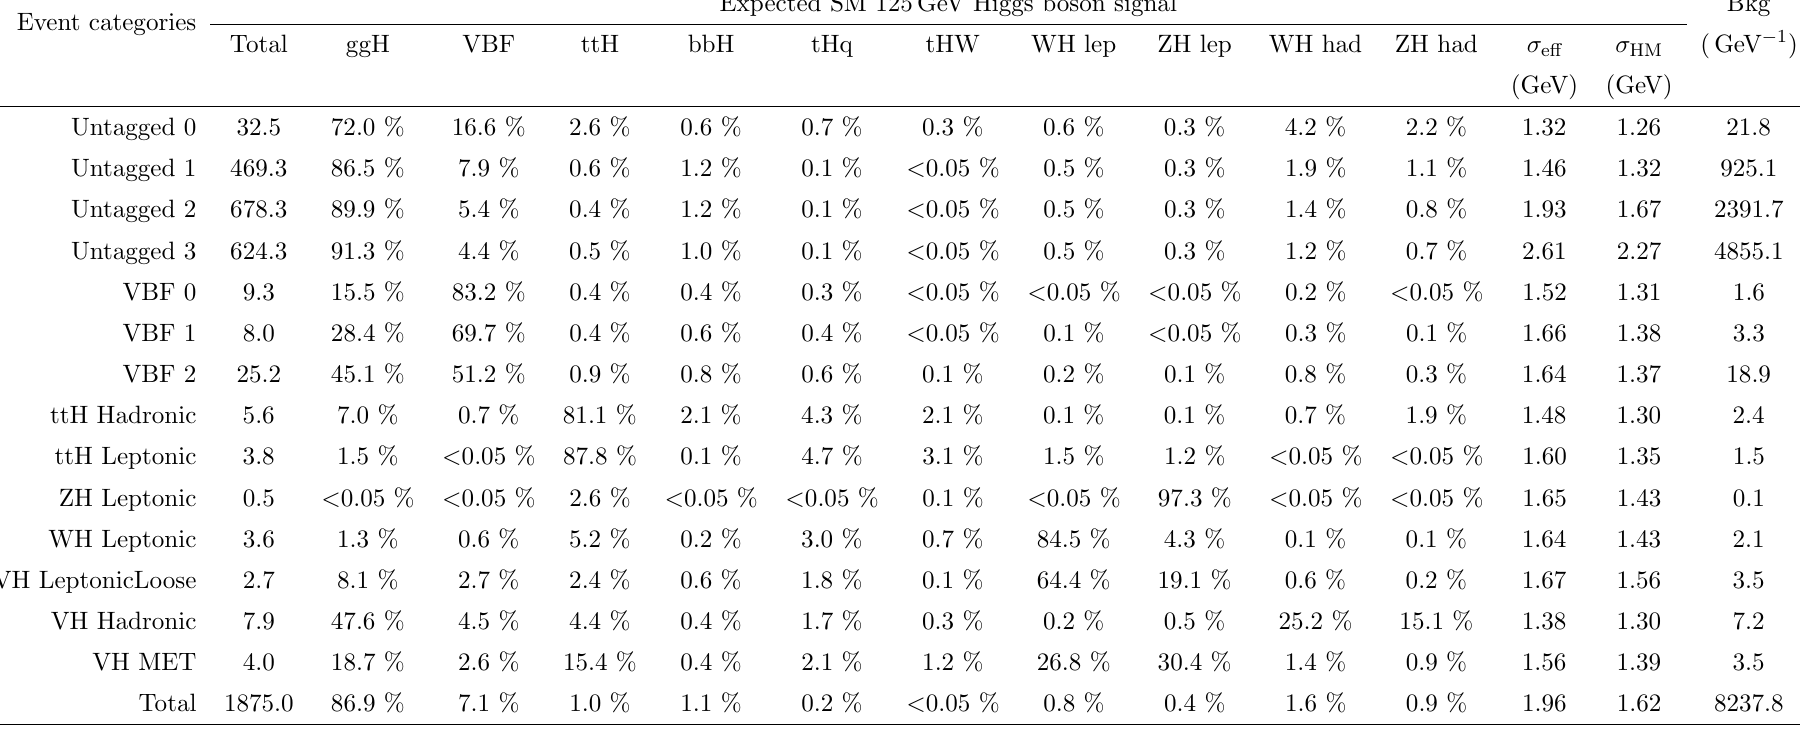
Table 3 . The expected number of signal events per category and the percentage breakdown per production mode in that category. The (cid:27) e(cid:11) , computed as the smallest interval containing 68.3% of the invariant mass distribution, and (cid:27) HM , computed as the width of the distribution at half of its highest point divided by 2.35, are also shown as an estimate of the m (cid:13)(cid:13) resolution in that category. The expected number of background events per GeV around 125 GeV is also listed.